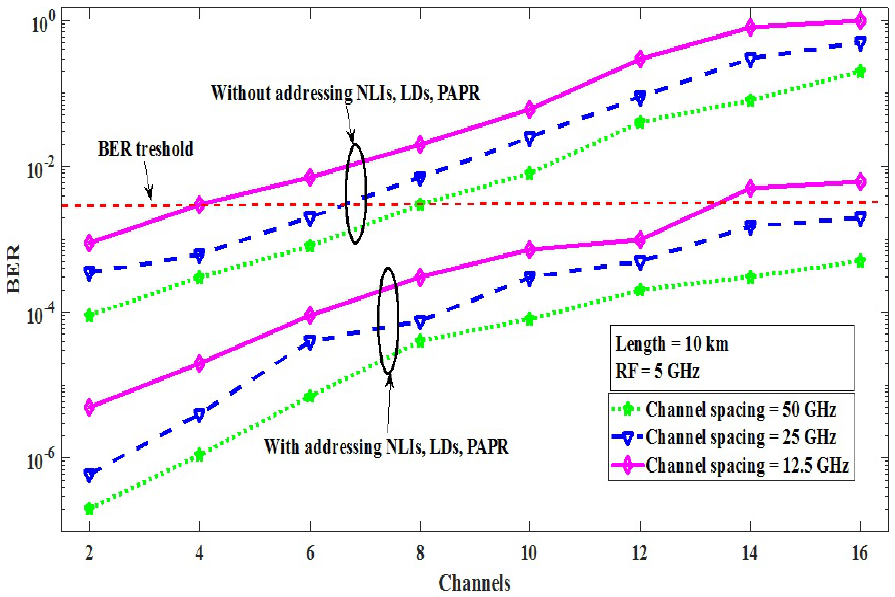
Figure 9. Channels as a function of BER at 12.5, 25 and 50 GHz channel spacing, length = 10 km and RF = 5